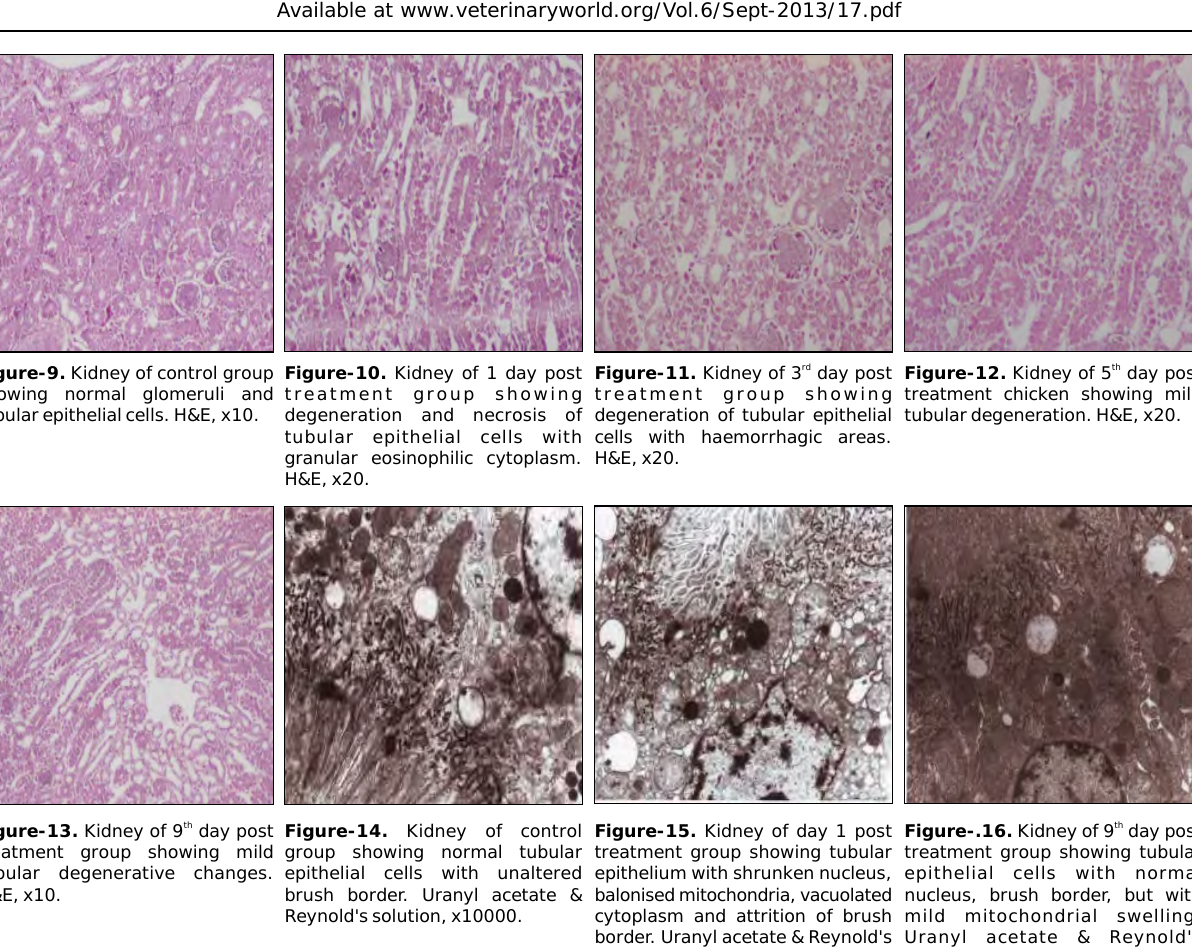
th Figure-13. Kidney of 9 day post Figure-14. Kidney of control group showing normal tubular treatment group showing mild epithelial cells with unaltered tubular degenerative changes. brush border. Uranyl acetate & H&E, x10. Reynold's solution, x10000.